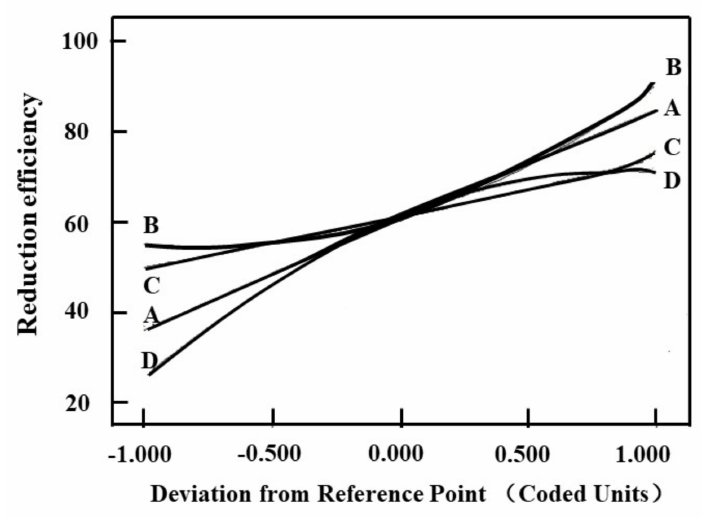
Figure 3. Perturbation plot for the reduction efficiency of Cr (VI) in the design space: ( A ) m (C)/m(Cr); ( B ) reaction temperature; ( C ) reaction time; ( D ) concentration of H 2 SO 4 .